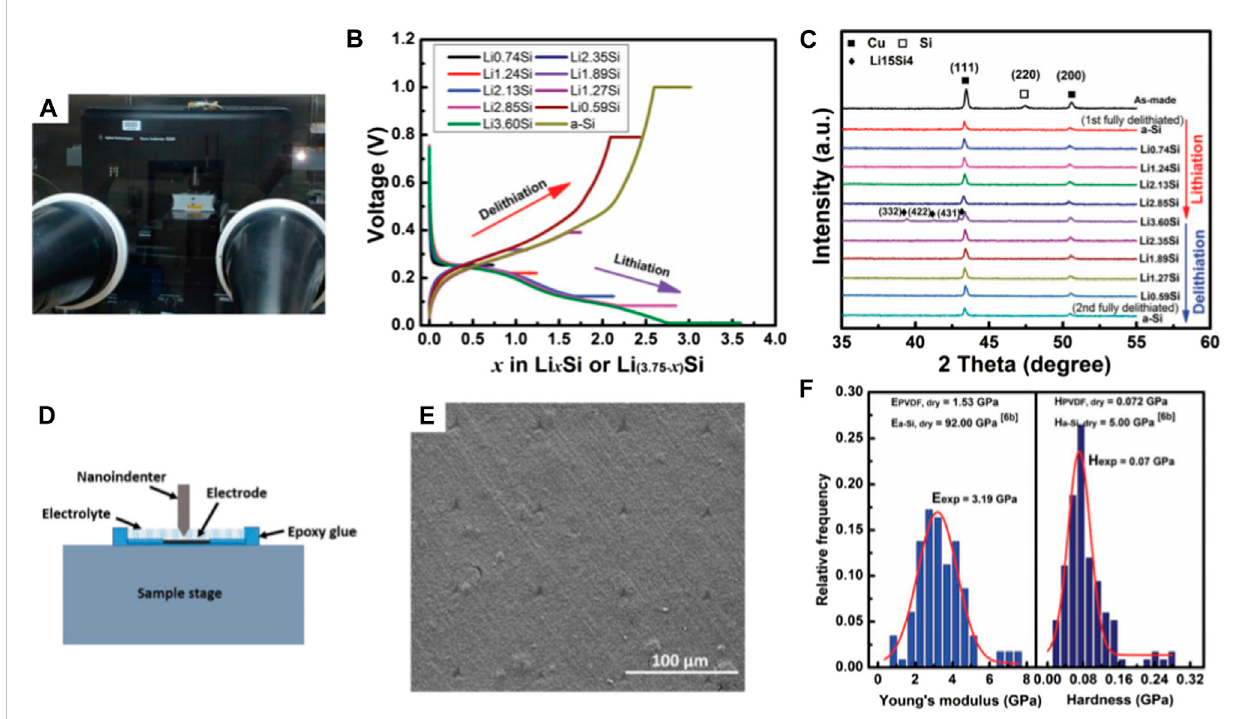
FIGURE 7 (A) The G200 nanoindentation system inside an argon- fi lled glovebox; (B) Voltage pro fi les of Si electrodes corresponding to different SOCs during the2ndcycle;ToobtainahomogeneousLidistribution,thegalvanostaticmodewasfollowedbyapotentiostaticmodeuntilthecurrentdensitydropped